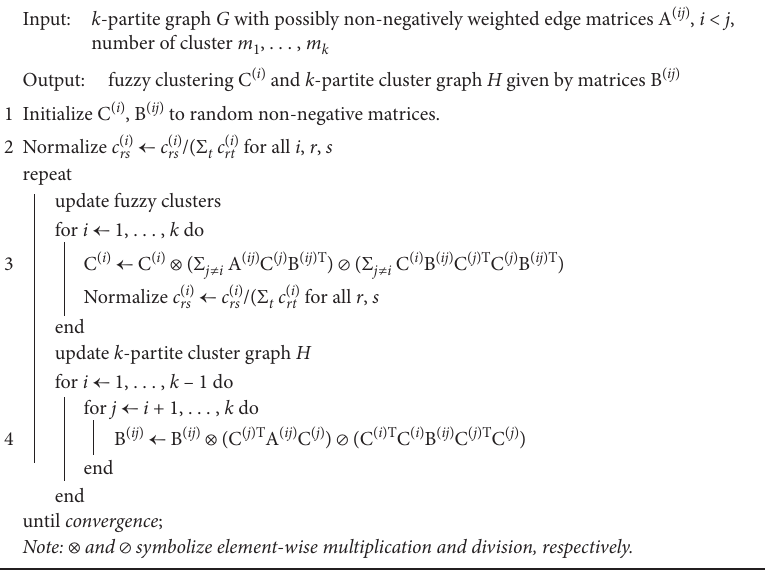
Figure 4: Fuzzy K-partite clustering